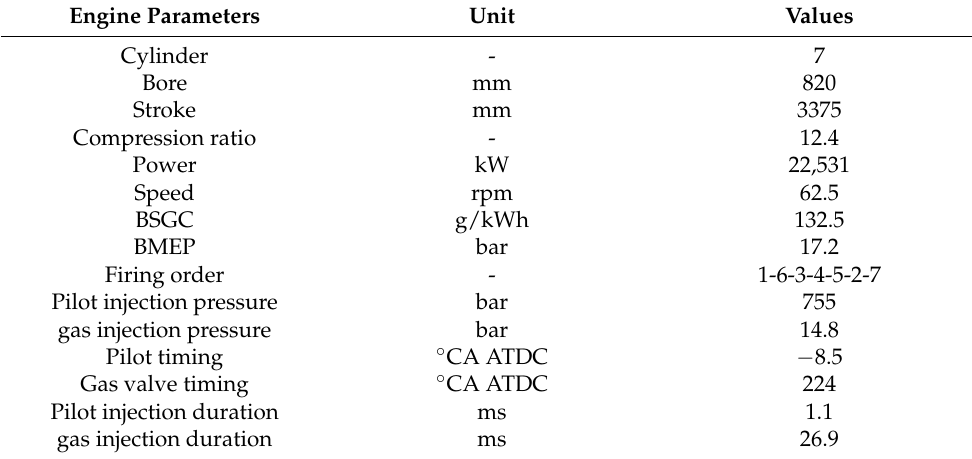
Table 1. Dual-fuel engine ’s main parameters.